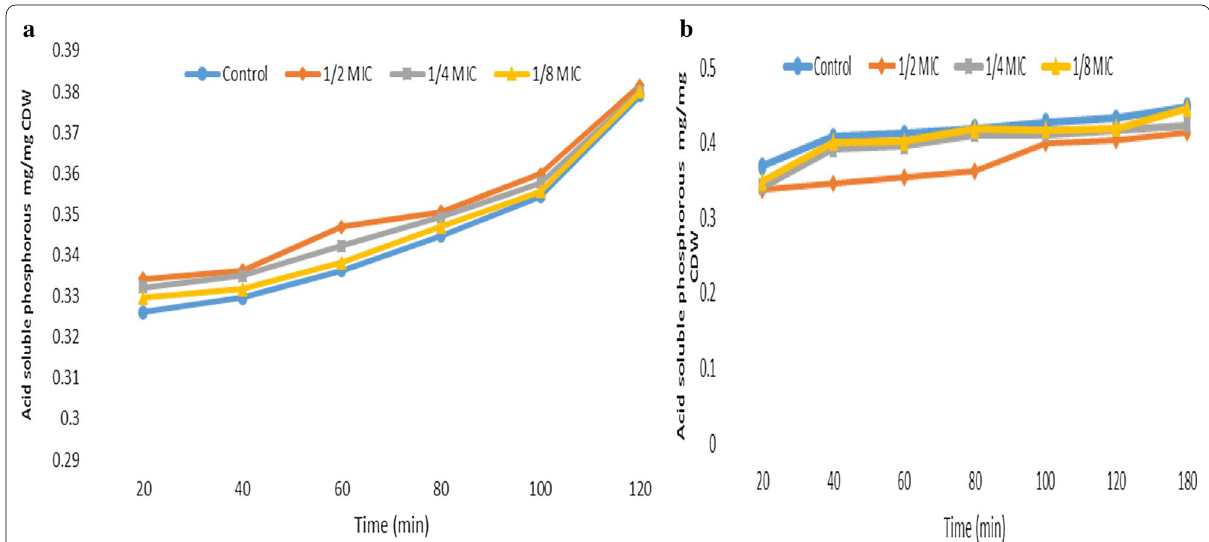
Fig. 1 Effect of different of Citrus lemon leaves oil on the acid soluble phosphorous biosynthesis in cells of P. aeruginosa ( a ) S. aureus (